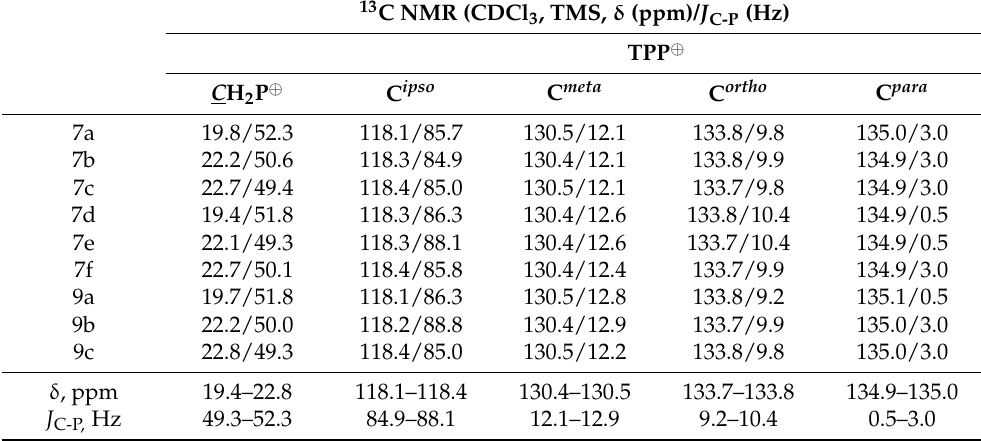
Table 1. The chemical shifts and coupling constants characteristic of TPP ⊕ moiety in the synthesized triphenylphosphonium analogs of BN ( 7 and 9 ).